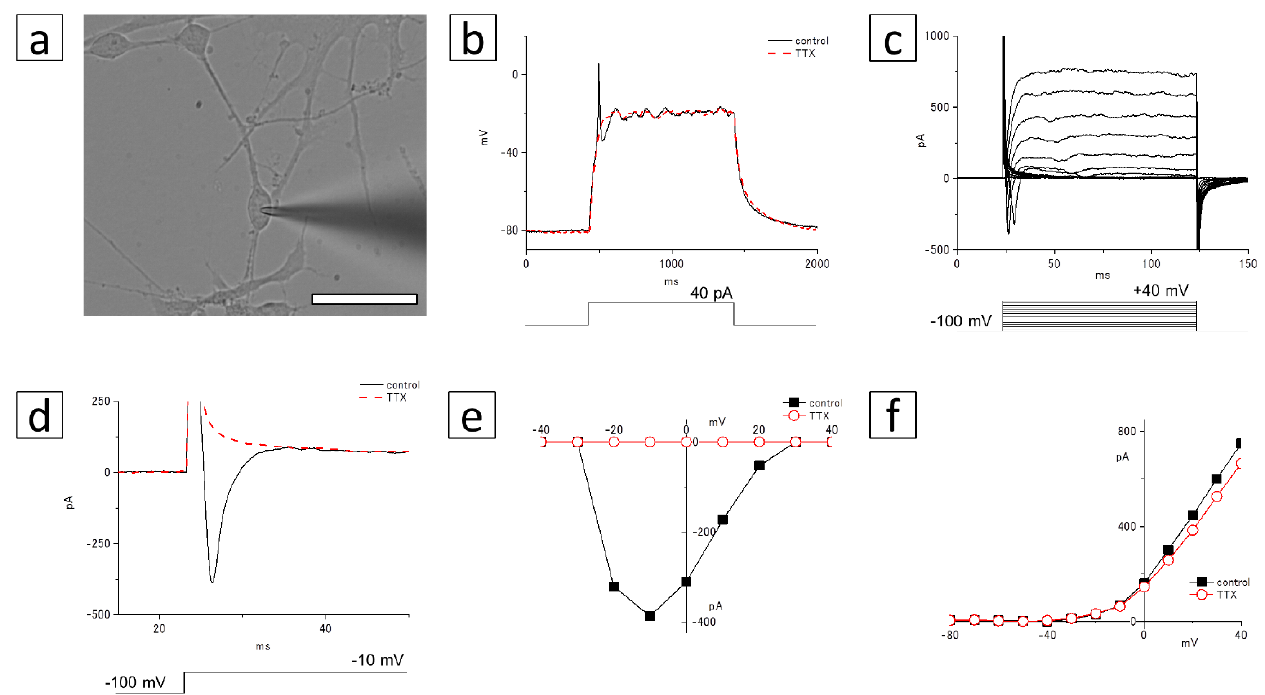
Figure 9. Patch-clamp recording of the Recoverin-positive cells. ( a ) A micrograph of the cultured cells. The patch electrode approaches the soma of the cell from the right side. Bar: 50 µm. ( b ) Responses to a depolarization induced by an injection of 40 pA current, recorded in control Ringer’s solution ( thin line ), and with the addition of 1 µM tetrodotoxin, a voltage-gated sodium channel blocker (TTX; dotted line ). ( c ) Membrane currents of the cultured cells by depolarizing voltage steps from a holding potential of −100 mV. Command voltages were increased in 10 mV steps from −100 mV to +40 mV. ( d ) Command voltages were increased to −10 mV in control solution ( thin line ) or 1 µM TTX ( dotted line ). The inward current at the beginning of the voltage-step was blocked by TTX. ( e ) The I–V relationship of voltage-gated inward currents. The peak inward currents in control solution ( filled squares ) or in 1 μM TTX ( open circles ) were plotted against the test-pulse voltage. ( f ) The I–V relationship of voltage-gated outward currents. The amplitudes of outward currents in control solution ( filled squares ) or in 1 μM TTX ( open circles ) were plotted against the test-pulse voltage.